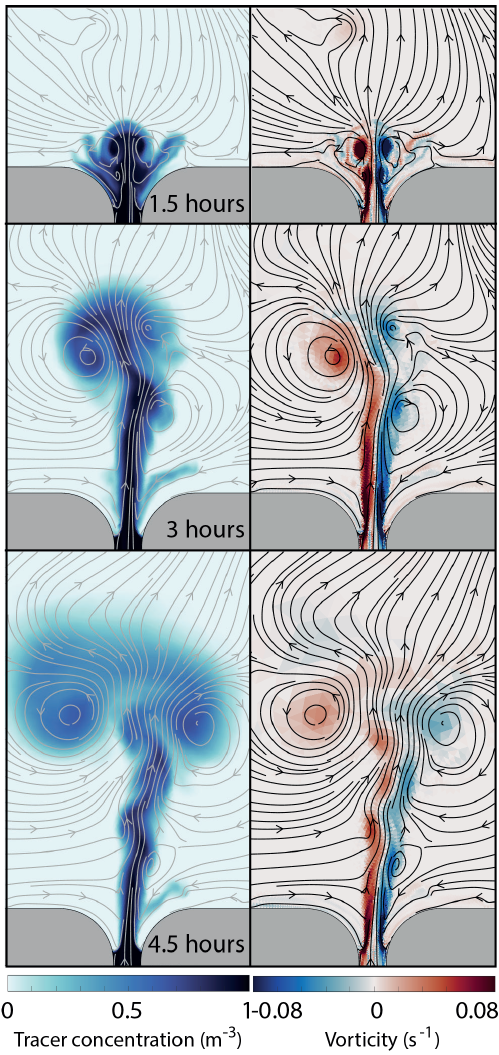
Figure 5. The temporal tracer and vorticity fields, with the corre- sponding stream function, are displayed for a 1km wide and 4km long strait in the left and right panel, respectively. The experiment is forced with a tidal wave of amplitude A t = 1m. The upper, mid- dle, and lower panels show a snapshot in time of the tracer and the vorticity fields at 1.5, 3, and 4.5h after slack tide,